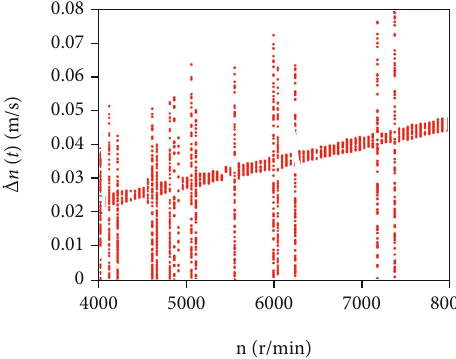
Figure 33: Bifurcation diagrams with changes in the rotation